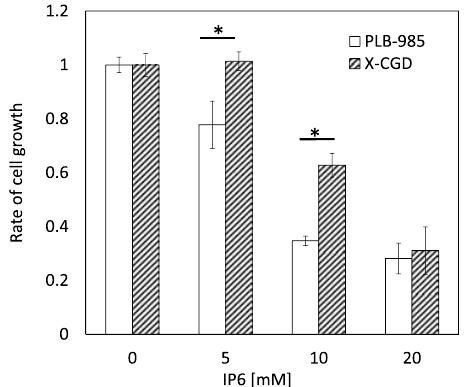
Figure 1 Effect of inositol hexaphosphate on the growth of PLB-985 and X chromosome linked gp91-phox gene knockout cells. Cells were incubated with inositol hexaphosphate for 24 h. Cell growth rate was assayed using a highly water-soluble tetrazolium salt, WST-8. Mean (±standard deviation) values from three independent experiments are presented. *P<0.05 (Student’s